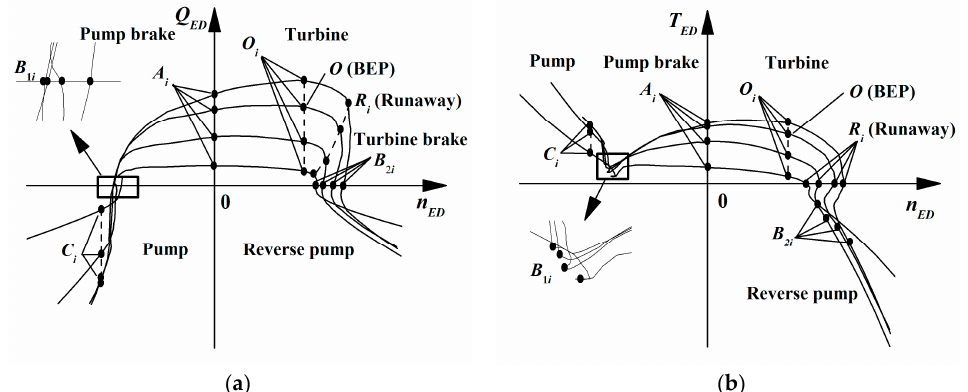
Figure 2. The distribution of COPs on the generic four-quadrant characteristic curves [30,34]: ( a ) Q n − characteristics; ( b ) T n − characteristics. ( a ) Q ED − n ED characteristics; ( b ) T ED − n ED ED ED ED ED